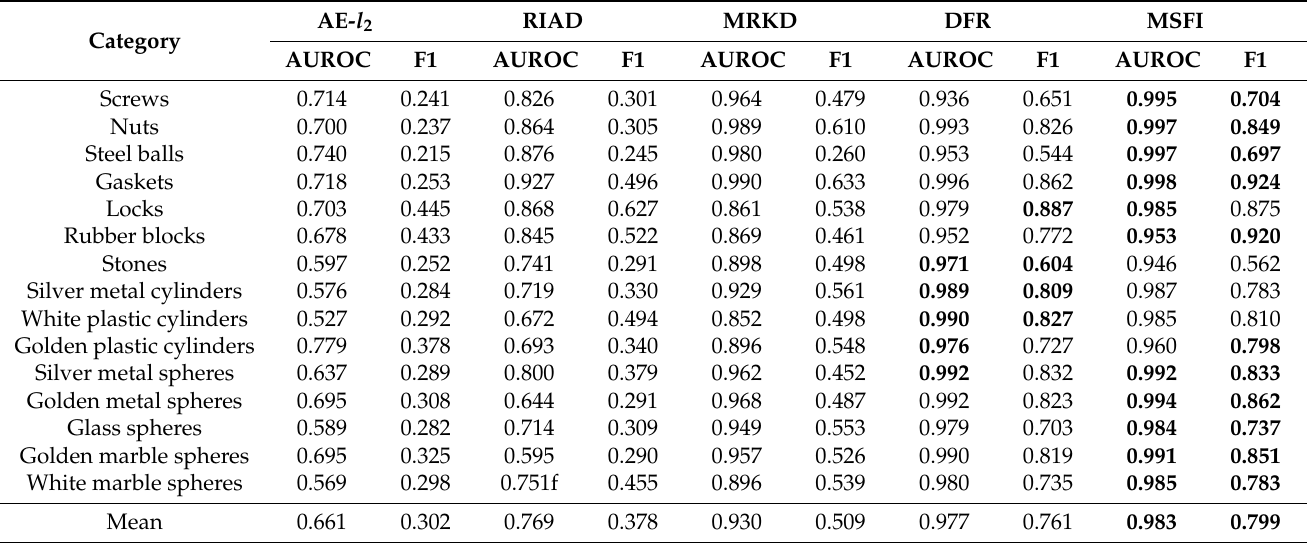
Table 4. The anomaly localization results on FOD dataset. The best result for each class is